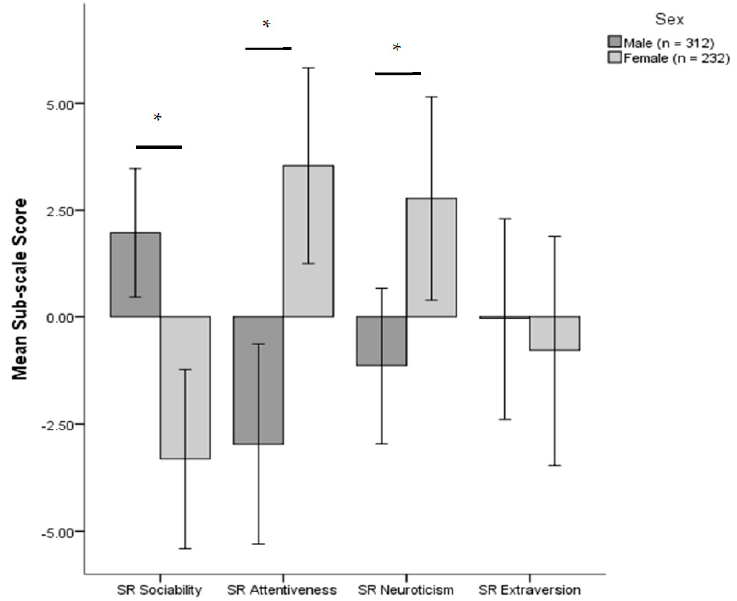
Figure 1. Mean subscale scores for each SR personality dimension, split by sex ± 2 standard errors. * indicates a significant difference between sex at the α = 0.05 level.